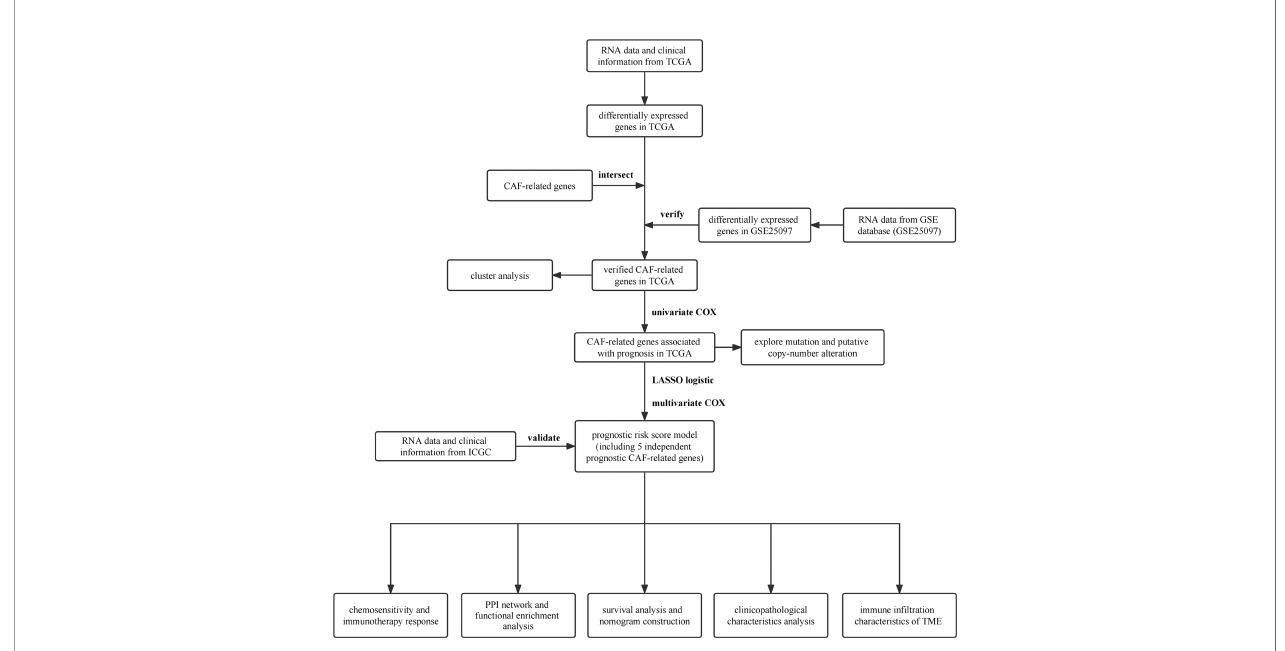
FIGURE 2 | Flow chart.